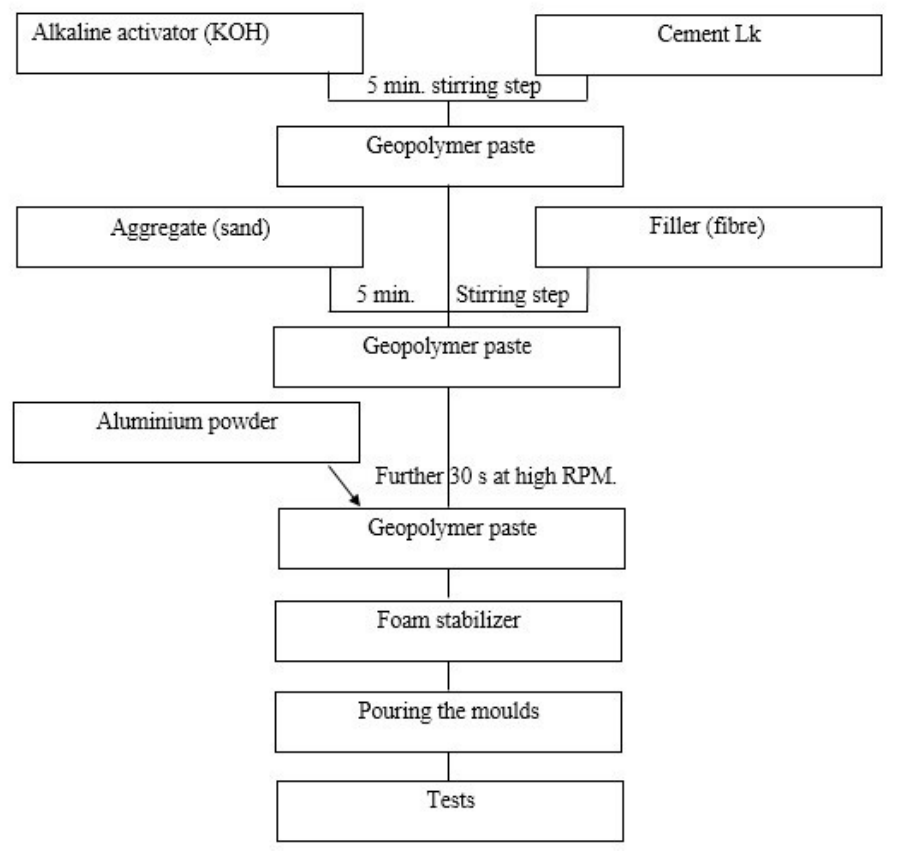
Figure 3: Schematic flowchart of geopolymer foams processing.